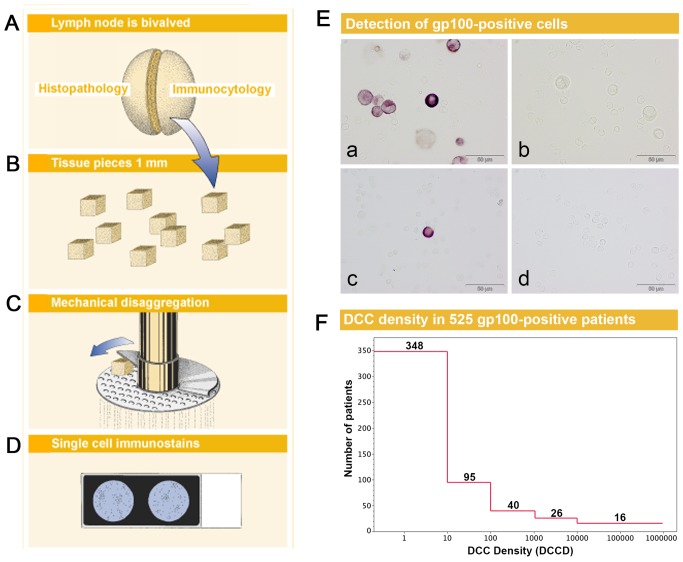
Sample preparation, melanoma cell detection, and distribution of disseminated cancer cell densities.(A) The sentinel nodes were split into halves for routine histopathology and immunocytology. (B–D) After mincing (B), the small pieces were subjected to mechanical disaggregation (C), and single-cell suspensions were added to adhesion slides (D). (E) The detection of gp100-positive cells among the unstained lymphocytes. (a) gp100 staining of Mel Ho cell line cells mixed among peripheral blood leukocytes used as positive control. (b) Isotype control of positive control. Note that the large melanoma cells can be identified by size among the peripheral blood leukocytes and are completely unstained. (c) gp100-positive cell from melanoma patient with DCCD = 1. (d) Isotype control of the melanoma patient in (c). All four samples are taken from the same experiment. (F) The distribution of DCCD (number of DCCs per 106 isolated cells) in the sentinel nodes of 525 gp100-positive patients. Note that some patients had DCCD <1. The 502 zero values for DCCD are not included.